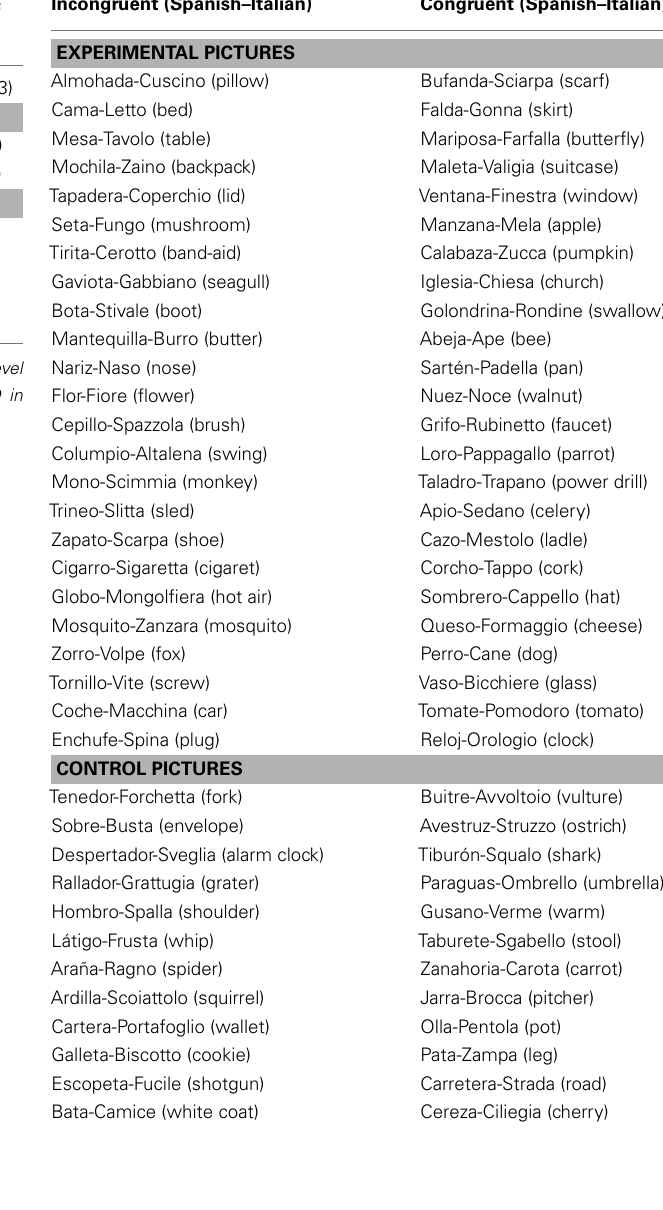
TableA2 | Stimulus